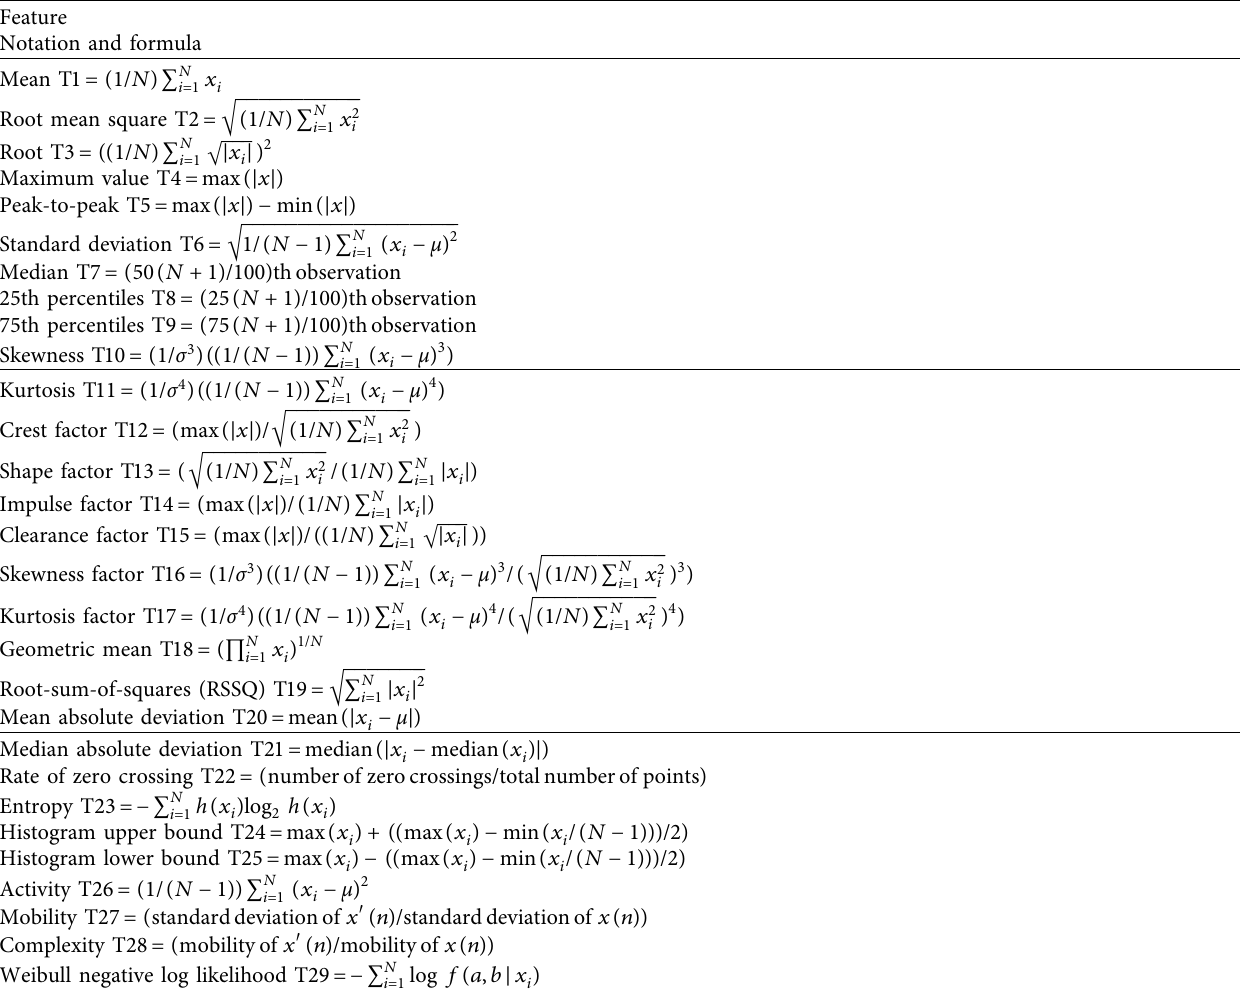
Table 1: List of statistical time-domain